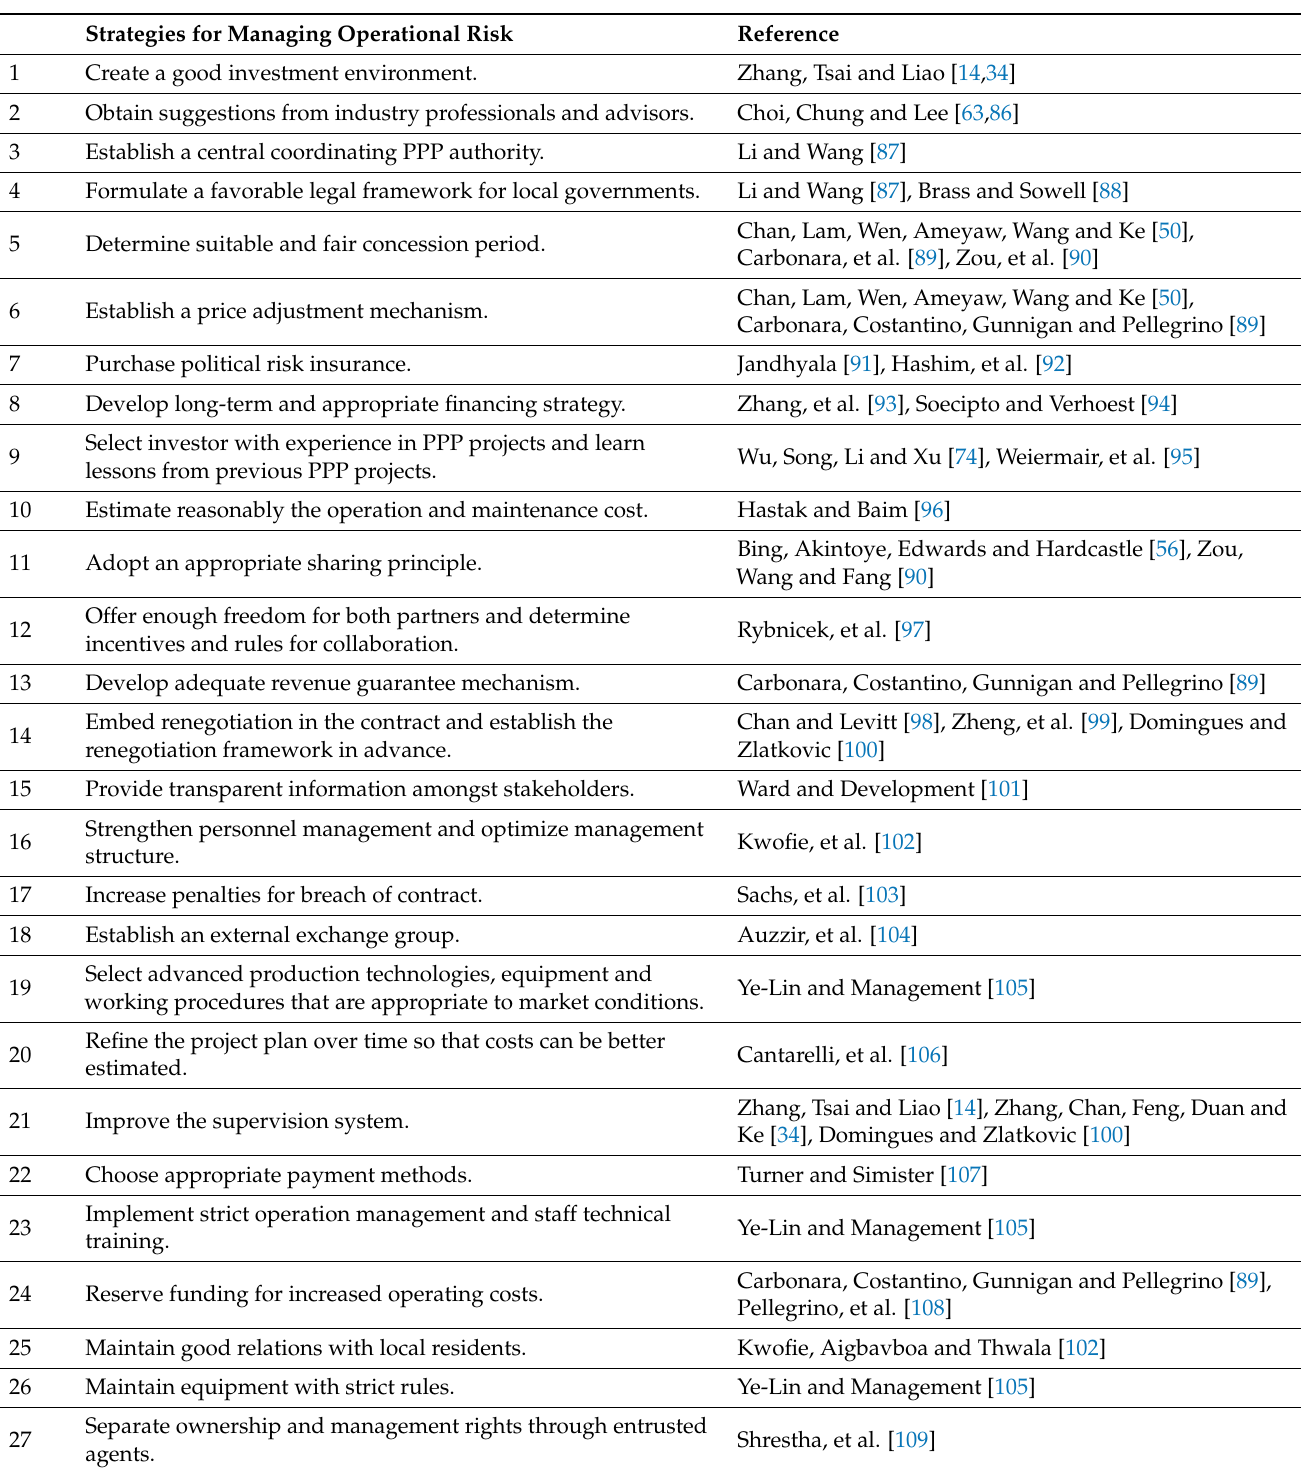
Table 3. Operational risk management strategies in PPP infrastructure